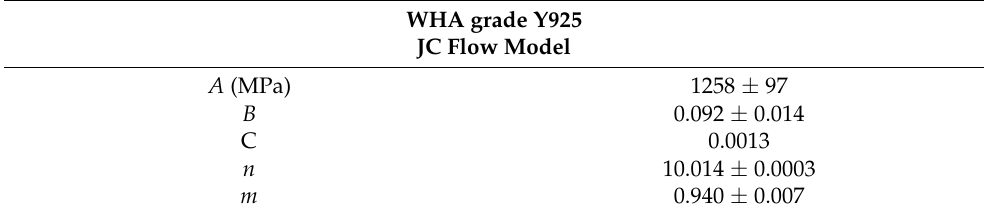
Table 4. Modelling parameters for the WHA Y925